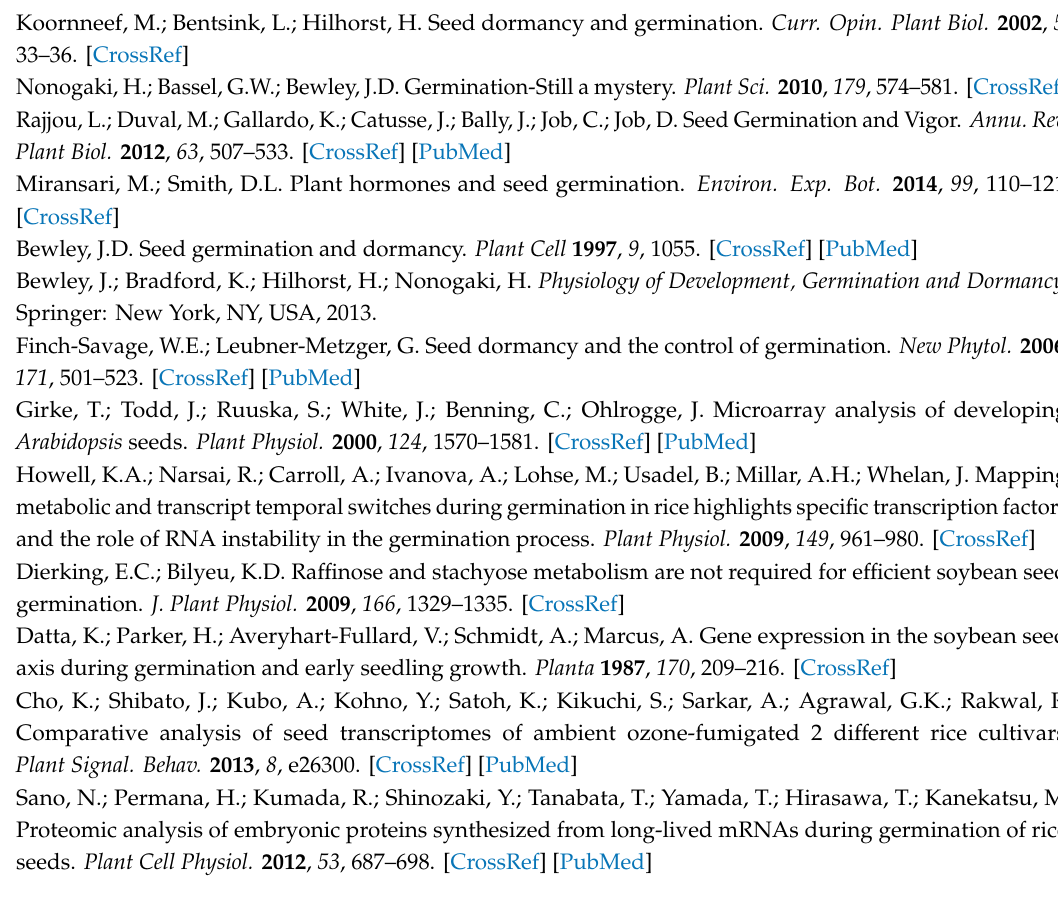
Table S1: Information on 285 metabolites annotated by qualitative matching analysis. Table S2: KEGG annotations of metabolites. Table S3: Pathways enriched at di ff erent seed germination timepoints. Table S4: Fold changes in metabolite abundances revealed by metabolite network